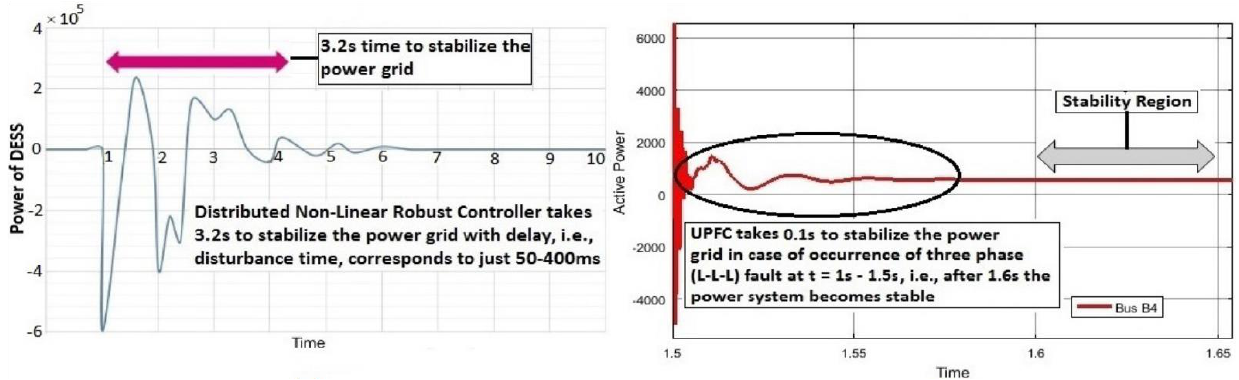
Figure 5. UPFC showing stability within a time interval of 0.16 s [53].